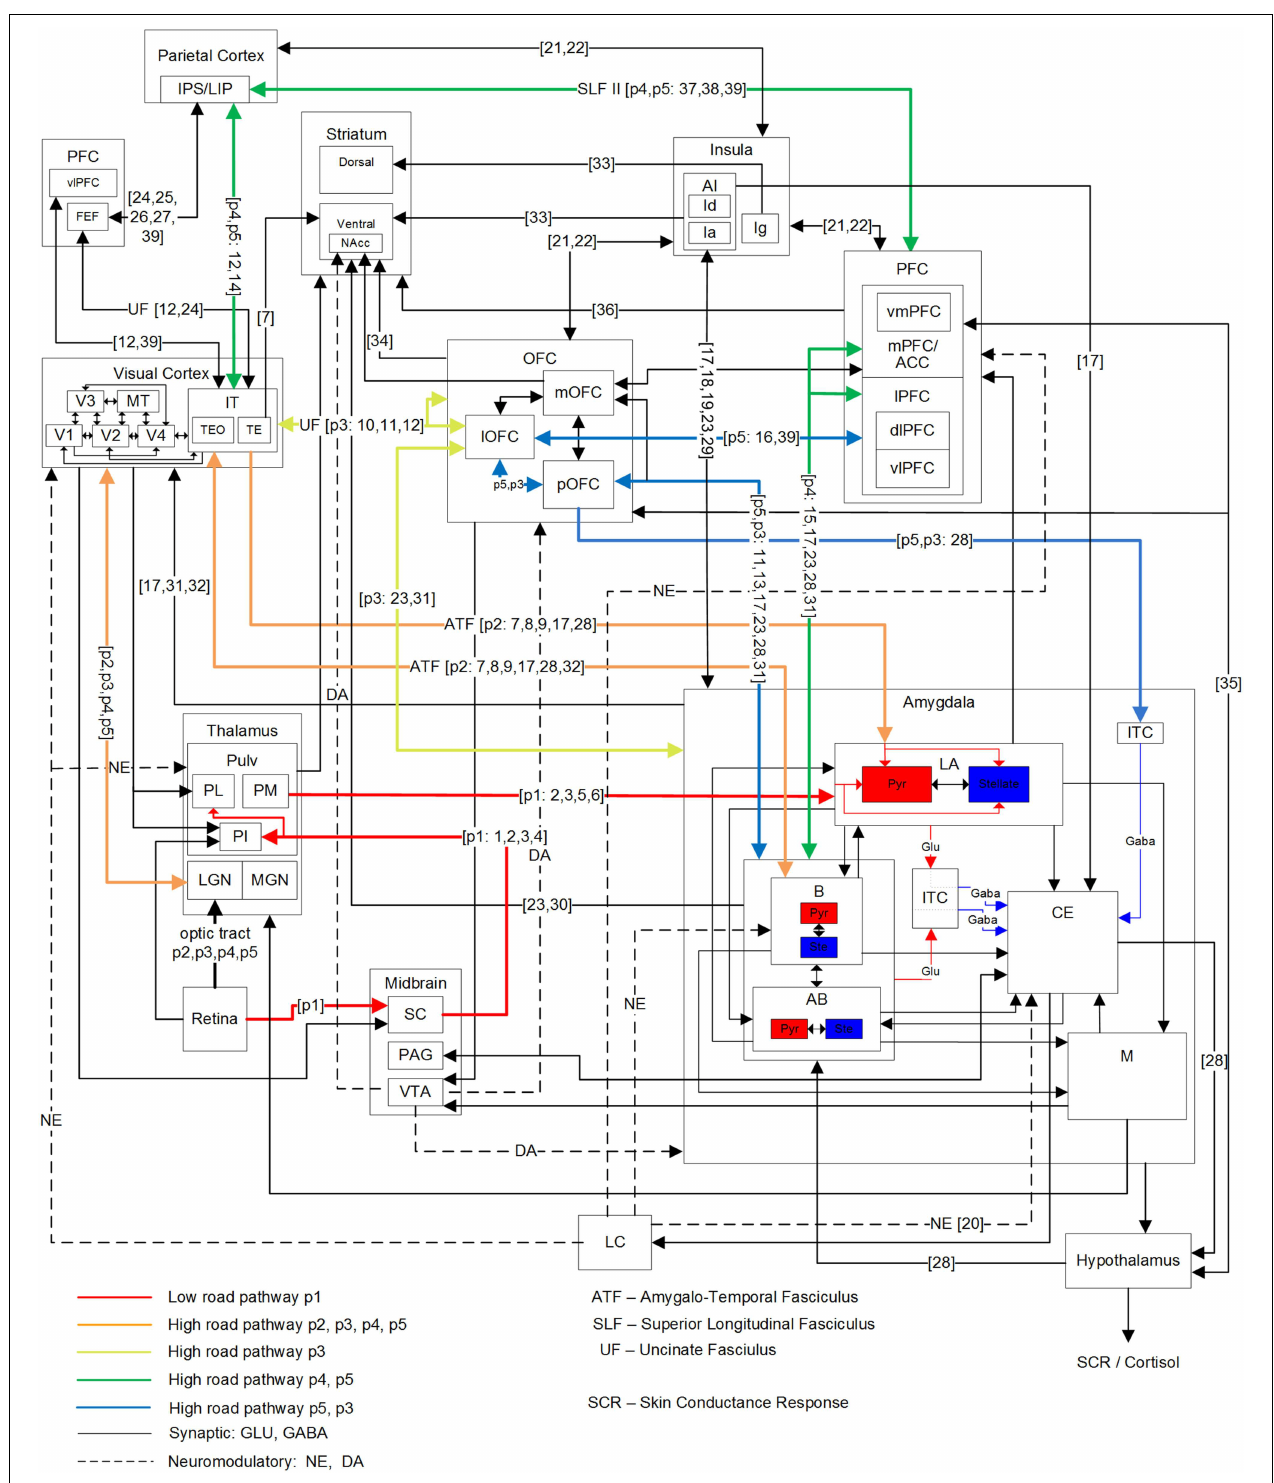
FIGURE 2 | Primate network diagram showing a subset of relevant brain areas and projections for visual fear signaling. Anatomical abbreviations are described in Table 1 . The proposed fear signaling pathways are labeled p1–p5. Projection preferences 1–39 are listed in Table 2 , which are not exhaustive. Hippocampus and